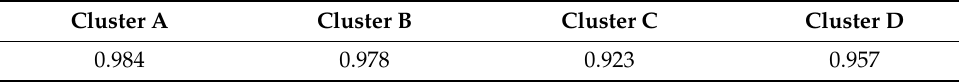
Table 5. PCC between single-output forecasting and actual electricity loads.